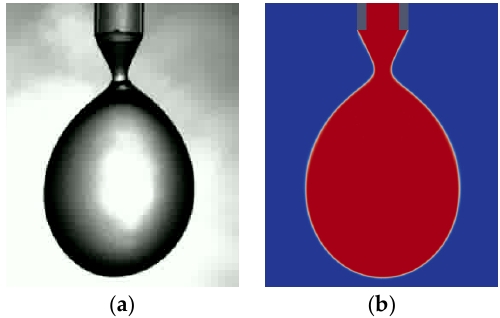
Figure 2. Hanging droplet near its point of detachment of the capillary: ( a ) Measurement; ( b )